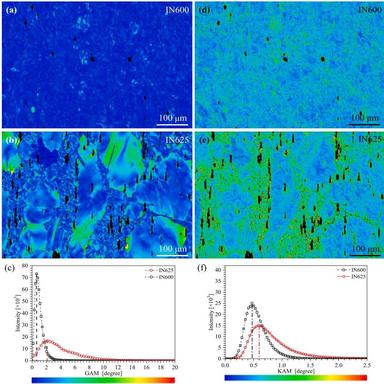
(a-c) GAM maps and GAM histrograms and (d-f) KAM maps and KAM histograms of the IN600 and IN625 alloys, respectively.